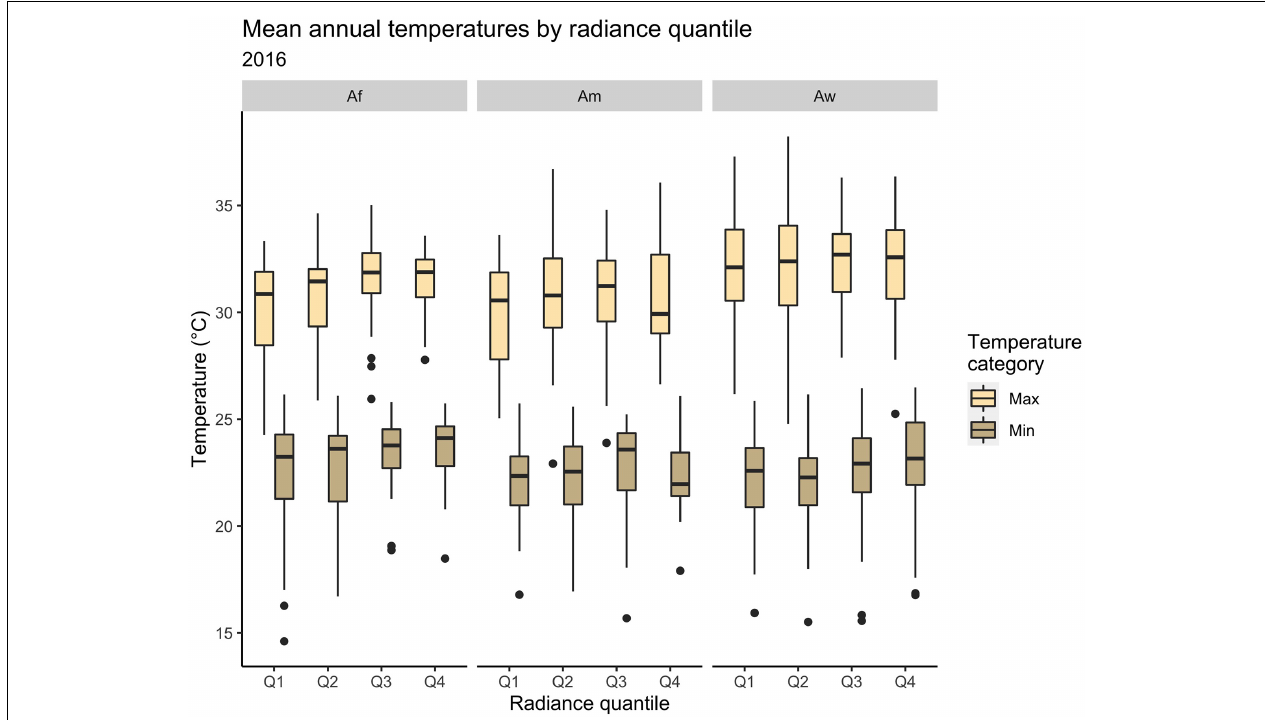
FIGURE 13 | Mean annual temperatures across nighttime lights radiance gradients. Data source: NOAA, GHCN and VIIRS, 2016.